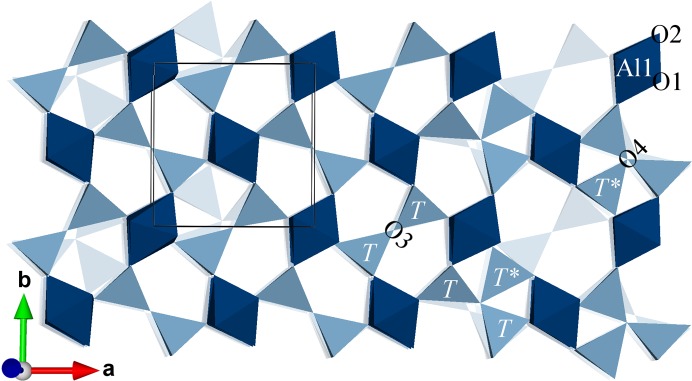
Structural elements of mullite and site labels. Subsequent layers are shown with decreased opacity. Chains of AlO6 octahedra (dark blue) are interlinked by diclusters consisting of two T sites and triclusters consisting of two T sites and a T* site. Two triclusters always embrace the void of an oxygen vacancy like the one between the two labelled T* sites. Octahedrally coordinated Al1 atoms are bonded to four O1 atoms and two O2 atoms. The bridging oxygens of diclusters and triclusters are labelled O3 and O4, respectively. Cations on the T site are labelled Al2 or Si2, and on the T* site Al3 or Si3. The unit-cell borders of the mullite average structure are marked by black lines.